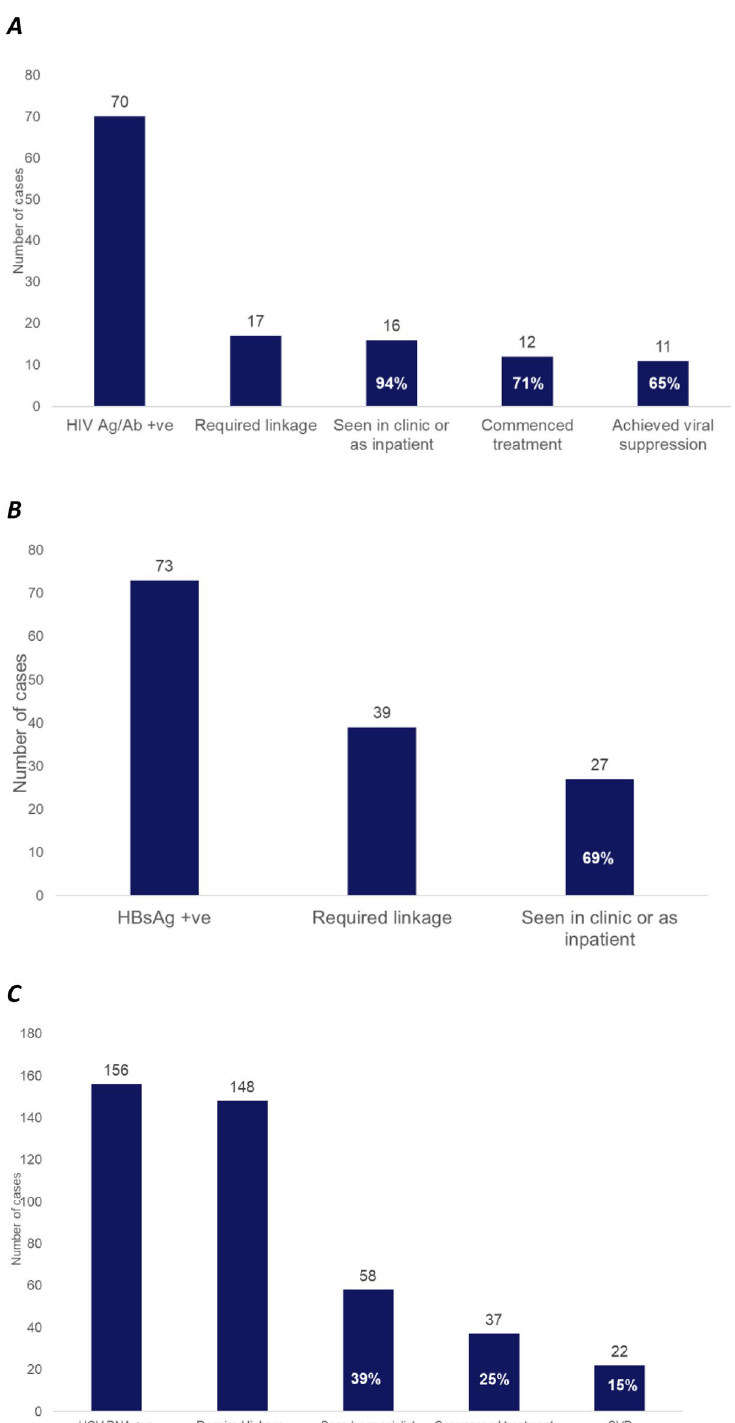
Figure 2. The care continuum within six months following diagnosis of ( A ) HIV infection, ( B ) HBV infection, and (C) HCV infection in the ED. Percentages shown use the number of patients requiring linkage to care as the